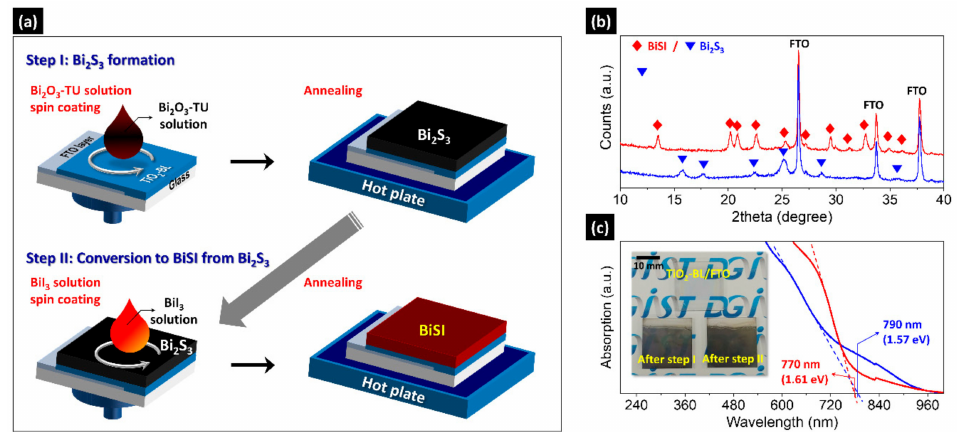
Figure 1. ( a ) Schematic diagram of the BiSI fabrication via the two-step solution process; ( b ) X-ray di ff raction (XRD) patterns; ( c ) absorption spectra of the samples prepared after step I (blue line) and step II (red line). Inset in ( c ): photograph of TiO 2 -BL / FTO and the two samples shown in ( b , c ). The samples were fabricated with the Bi 2 O 3 -TU solution of Bi:S = 1:3 molar ratio on TiO 2 -BL / FTO